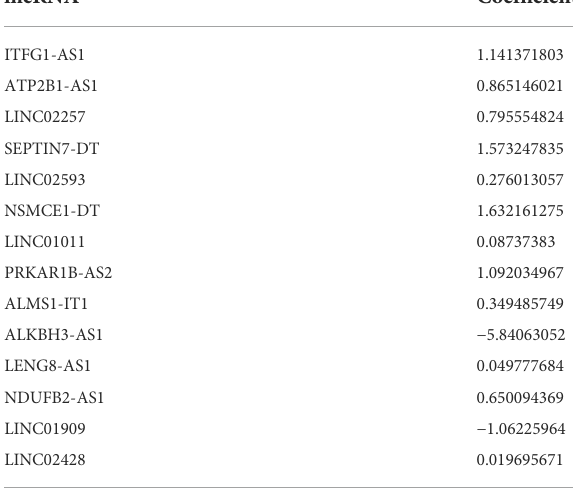
TABLE 2 The risk coef fi cient of lncRNAs that comprise the prognostic